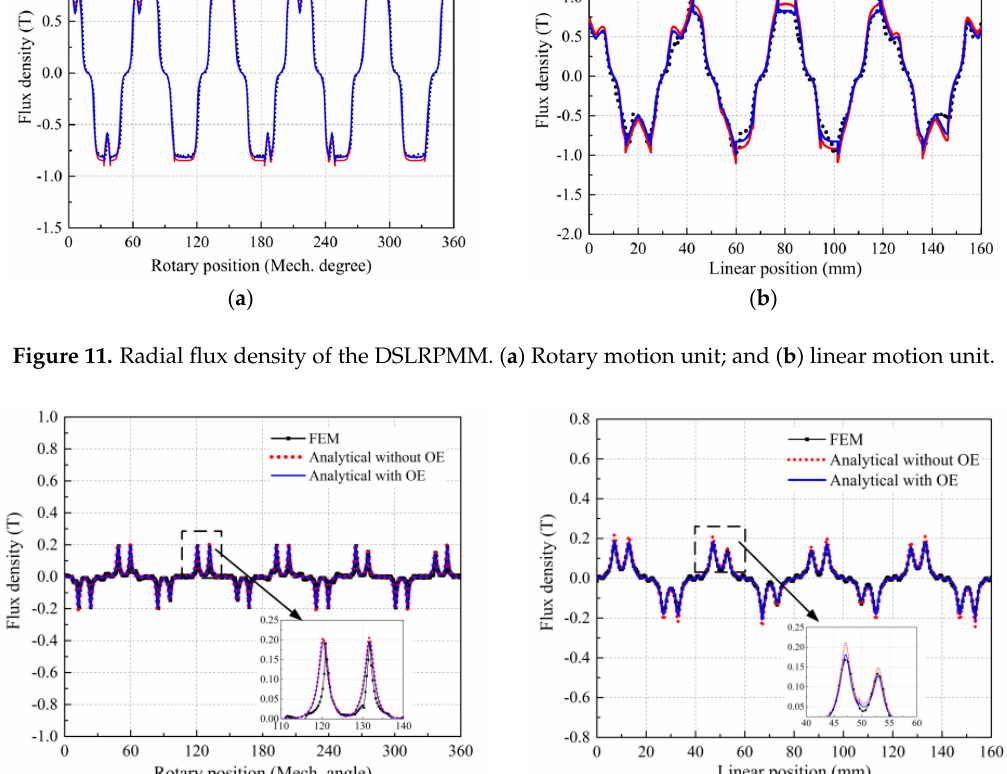
Figure 12. Tangential flux density of the DSLRPMM. ( a ) Rotary motion unit; and ( b ) linear motion unit.